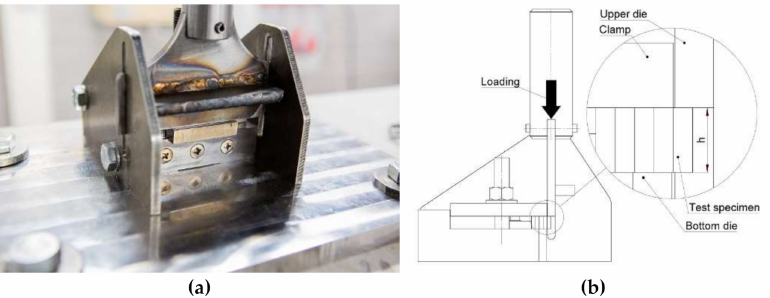
Figure 3. Test setup for the shear strength ( a ) experimental setup; ( b ) schematic drawing.